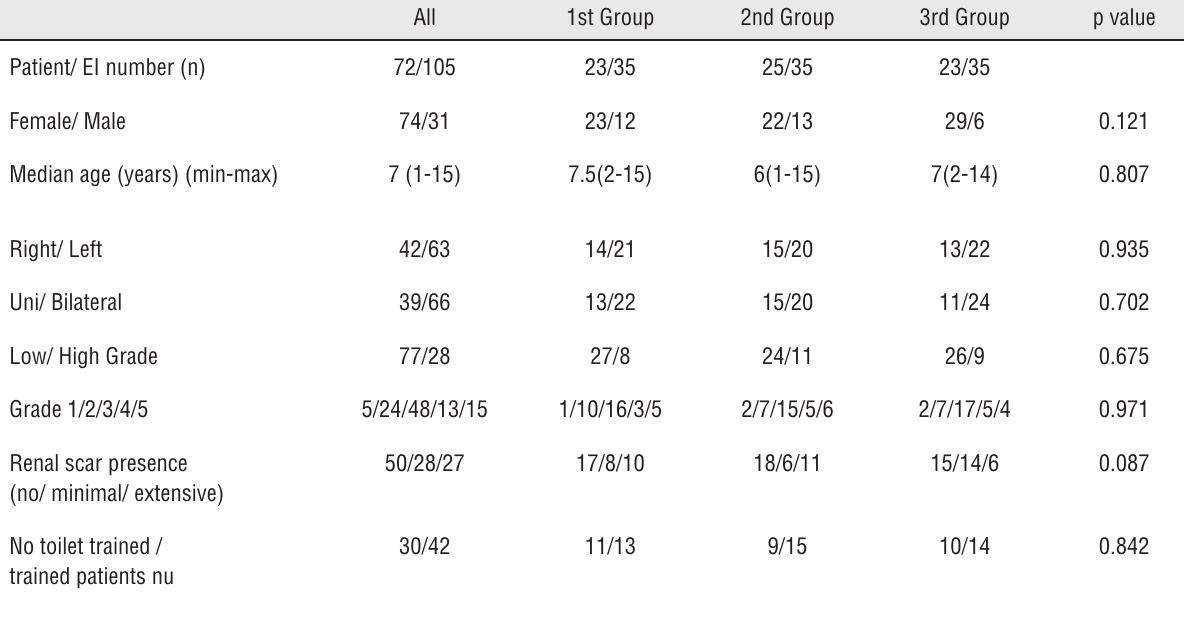
Table 1 - Descriptive analyze of the studied population (*: p value is significant under 0.05). All 1st Group